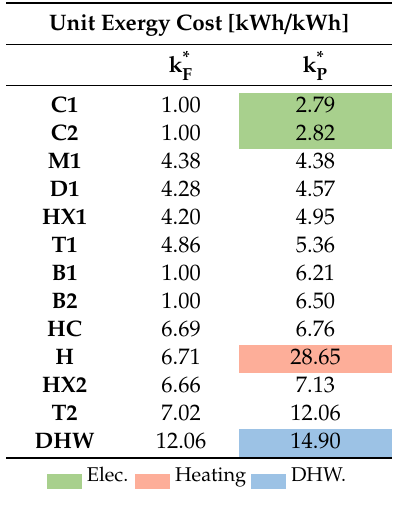
Table 4. Unit exergy costs of each component fuel and